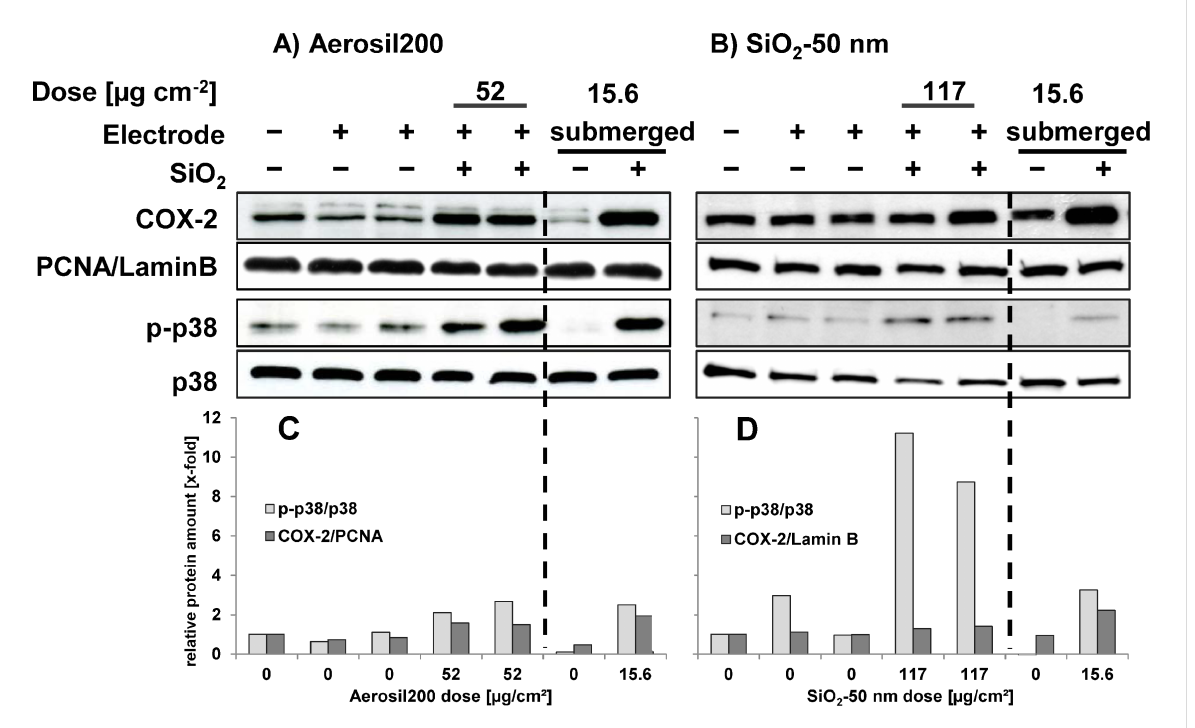
Figure 9: Induction of COX-2 und phosphorylation of p38 in A549 cells after SiO 2 -NP treatment under submerged and ALI conditions. A549 cells were exposed to filtered air or to an aerosol containing Aerosil200 NPs (A) and SiO 2 -50 nm NPs (B) as described in Figure 7 above. COX-2 and phospho-p38 were detected in whole cell lysates by Western blots. PCNA (left panel), Lamin B (right panel) and total p38 were used as loading controls, as indicated. The results shown are representative for three (A) and two independent experiments (B). (C) and (D) show the quantification of the p-p38 and COX-2 bands normalized to the loading controls (total p38 and PCNA or Lamin B, respectively), which are compared to the ALI controls exposed to clean air without electrode (which are set to 1).